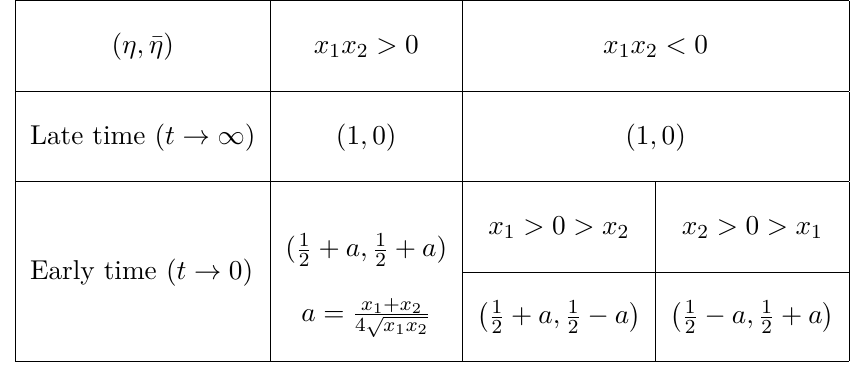
Table 1. Early time and late time behaviors of ( η, ¯ η ) for the subsystem A = [0 , ∞ )